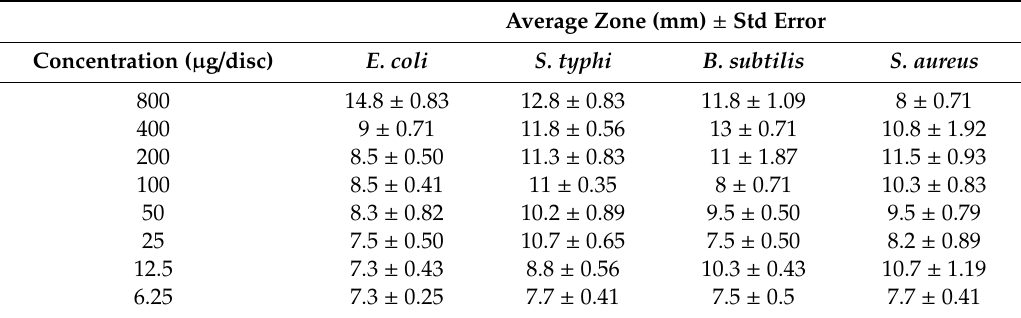
Table 2. Mean values and standard error of inhibitory zones generated by the antimicrobial compound for Gram ( + ve) and Gram ( − ve)